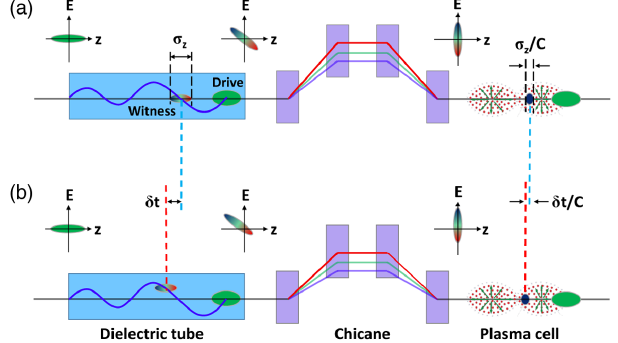
5. PWFA with externally injected beam. (a) The injected beam is perfectly timed with the drive beam; (b) The witness beam is injected with timing jitter which is smaller than the half of the wakefield wavelength in the dielectric tube. Both the bunch length σ z and timing jitter δ t of the witness beam will be reduced by the compression factor C